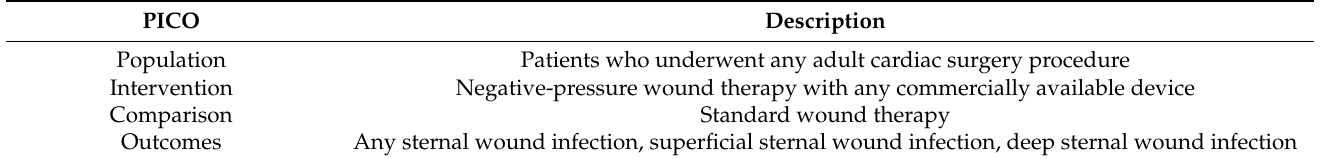
Table 1. Population, intervention, comparison and outcomes (PICO) of the present meta-analysis. PICO Description